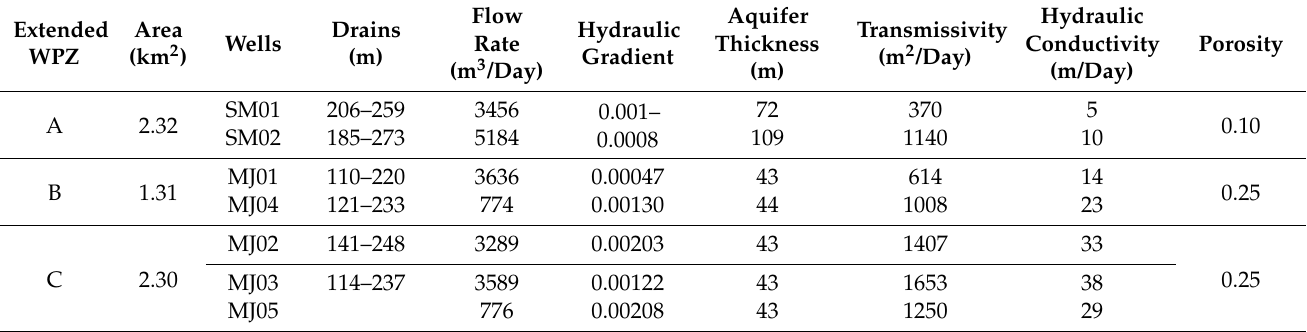
Table 1. Hydrogeological parameters and wells technical features used in the application of analytical methods to calculate the WPAs in